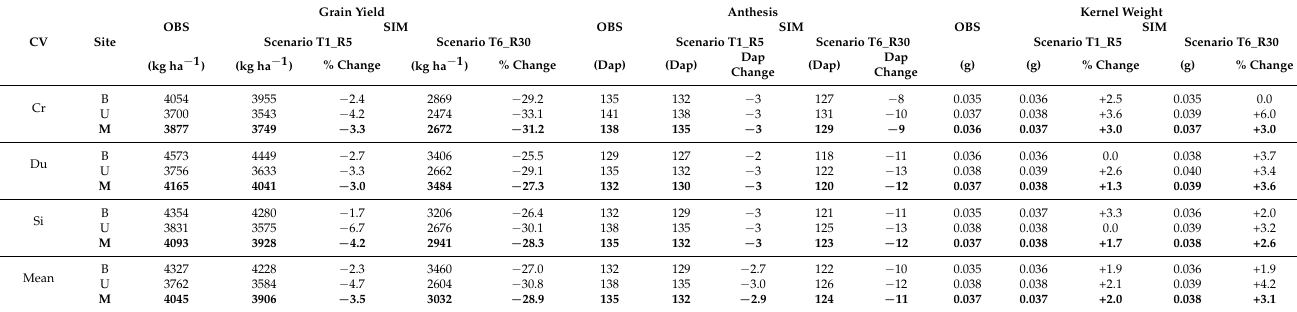
Table 4. Simulated responses of three durum wheat cultivars (Creso—Cr, Duilio—Du, Simeto—Si) to two climate change scenarios (T1_R5 and T6_R30) at Benatzu (B) and Ussana (U) experimental sites in Sardinia, Italy. T1_R5 and T6_R30 scenarios project an average temperature increase of 1 ◦ C and 6 ◦ C, respectively, and an annual rainfall reduction of 5% and 30%, respectively. Simulation results (SIM) and means (M) of grain yield (kg ha − 1 ), date of 2004 at Benatzu and 1989–2004 at Ussana.